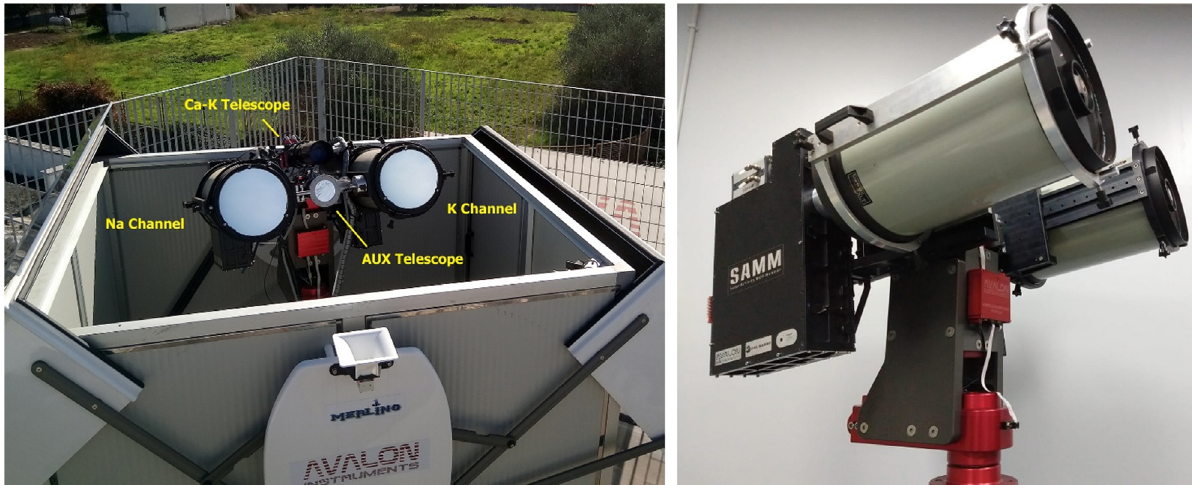
Fig. 1. Left: the fi rst SAMM node installed on top of the Avalon Instrument Headquarters near Rome. On top of the SAMM we have two telescopes: one is equipped with a Ca – K fi lter to preliminary detect and check the pointing on the magnetic structures we want to observe, a smoller one (Aux) is used for the mount setup and can be used also at night since has a removable neutral density fi lter. Right: the SAMM prototype in the lab.